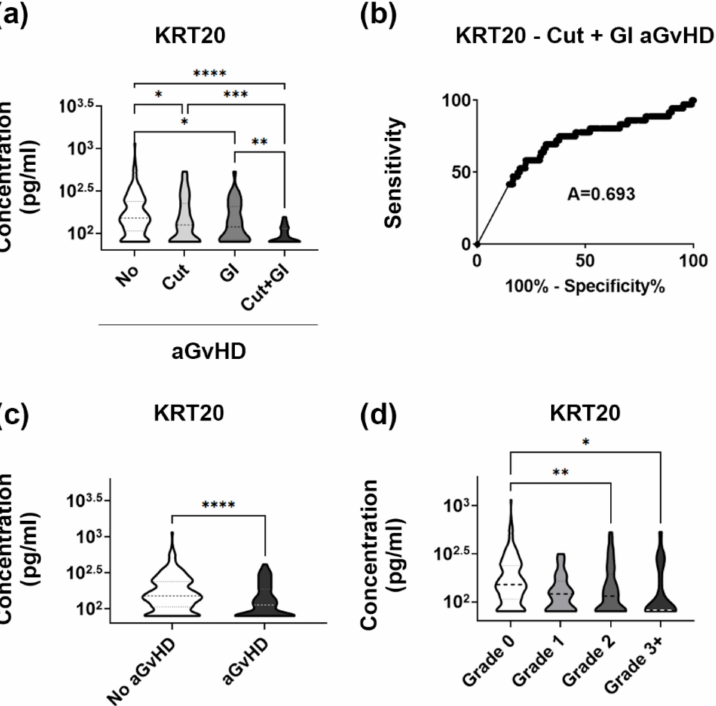
Figure 4. Validation of KRT20 as a putative biomarker of aGvHD with multiple organ involvement in a validation cohort. ( a ) KRT20 levels in aHSCT patients without GvHD compared to patients developing aGvHD affecting the skin, the gut, or both the skin and the gut in the validation set. Summarized results of a cohort study analysing blood protein levels at select time points before and after aGvHD diagnosis, using commercial ELISA assays (Kruskal-Wallis test, stars indicate results of post hoc tests; * p < 0.05, ** p < 0.01, *** p < 0.001, **** p < 0.0001) Abbreviations: No, no aGvHD; Cut, cutaneous aGvHD; GI, gastrointestinal aGvHD. ( b ) Sensitivity and specificity KRT20 as a marker of aGvHD involving the skin and the gut (receiver operating characteristic, area under the curve shown). ( c ) Plasma KRT20 in aHSCT patients affected or unaffected by aGvHD ( t -test; **** p <